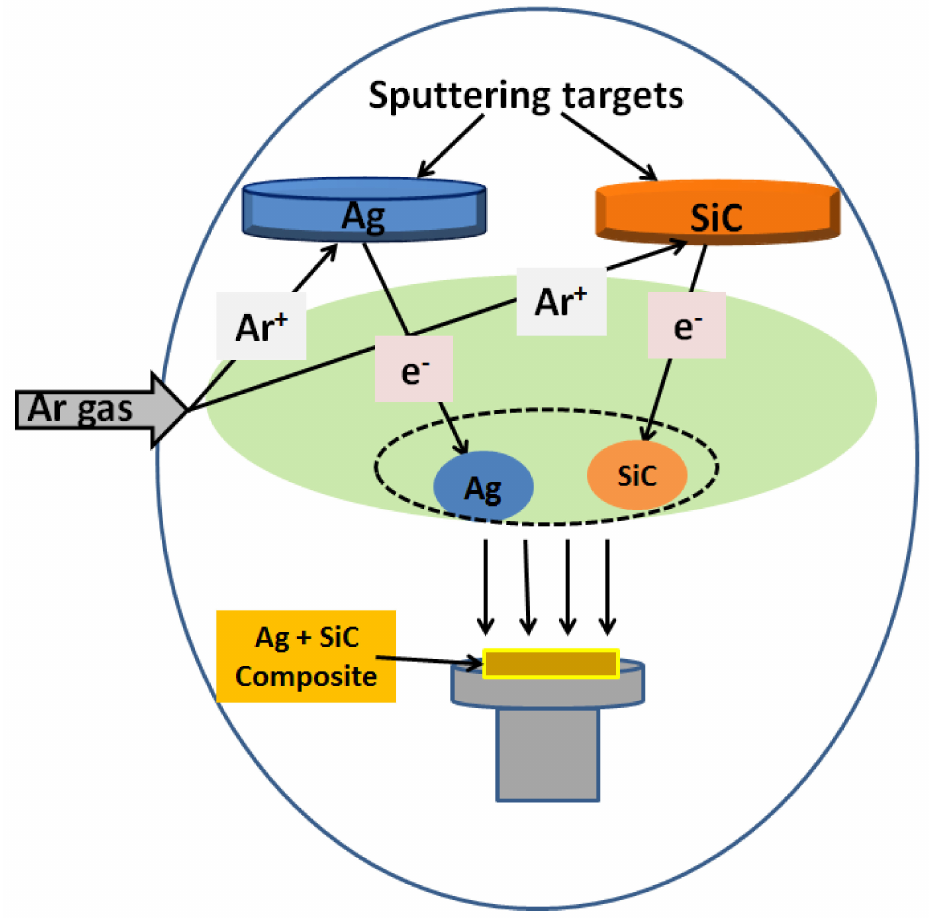
Figure 1. Schematic diagram of the sputtering geometry used to prepare the composite thin-film